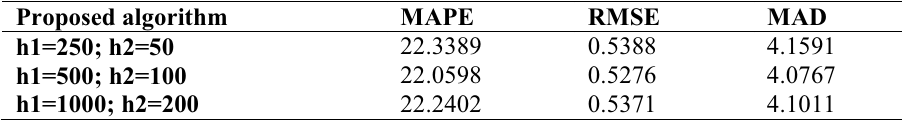
Table 7. MAPE, RMSE and MAD values of various hidden layers in proposed technique for dataset 2 Proposed algorithm